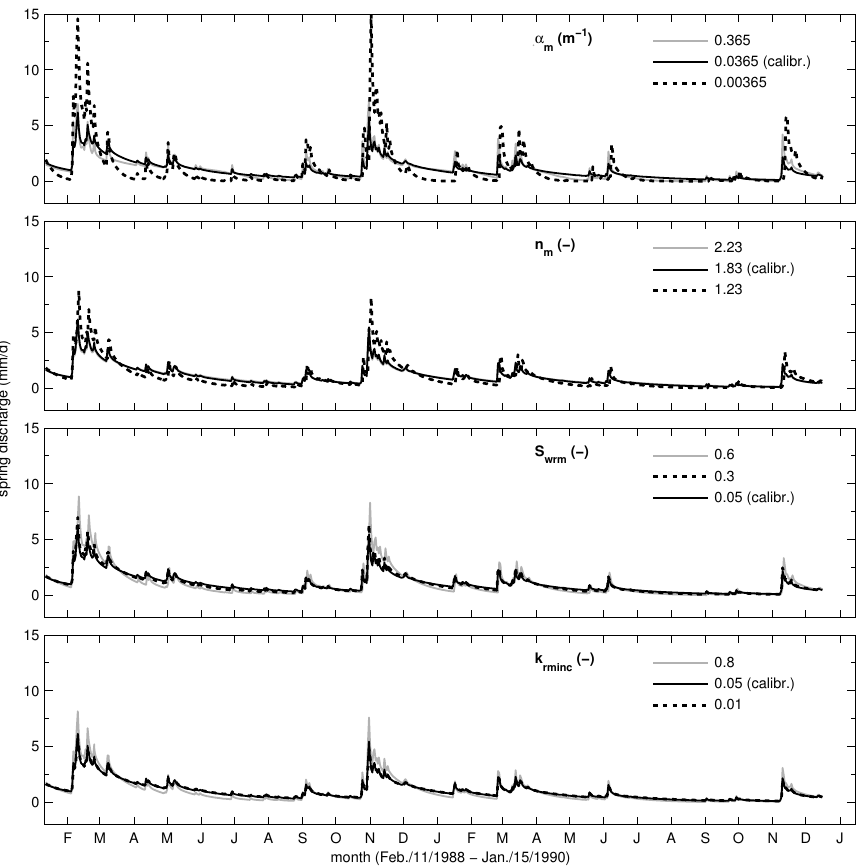
Fig. 8. Variation of the van Genuchten parameters ( α m , n m , S wrm , k rminc ). Table 3. Parameter combinations used for the sensitivity analyzes and highest RMSE (mmd − 1 ) observed. Bold RMSE values denote a non-linear inter-parameter